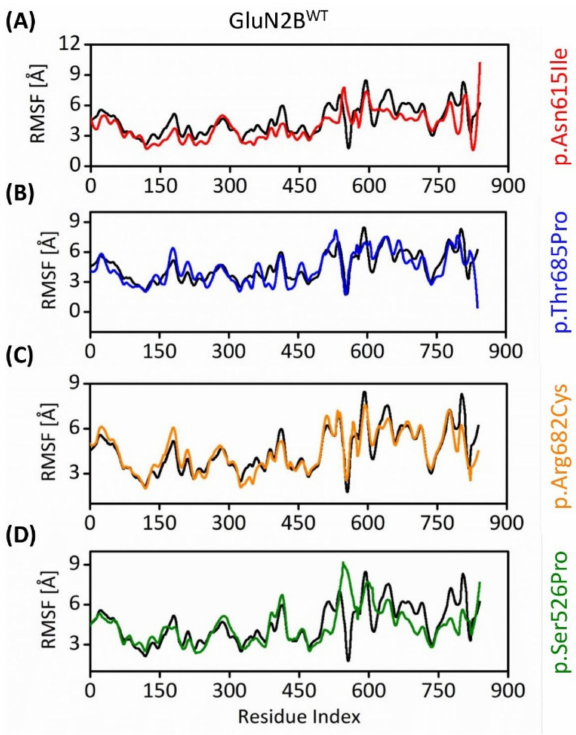
Figure 5. RMSF plot manifesting the collective flexibility of GluN2B WT protein model with ( A ) GluN2B p.Asn615Ile , ( B ) GluN2B p.Thr685Pro , ( C ) GluN2B p.Arg682Cys , and ( D ) GluN2B p.Ser526Pro . The black color in the line graph represents the RMSF of GluN2B WT